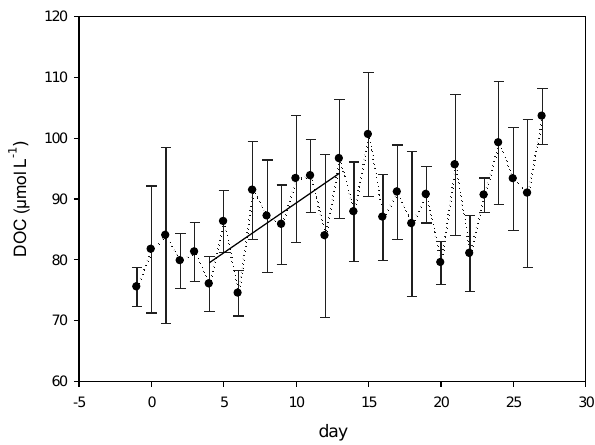
Fig. 10. Average concentration of dissolved organic carbon (DOC) in the course of the mesocosm experiment as determined from depth-integrated samples of the nine mesocosms. Error bars give ± 1SD. Between days 4 and 13 (nutrient addition), DOC increased significantly over time ( r 2 = 0.45, n = 10, p = 0.01), whereas no significant increase of DOC concentration was observed afterwards.